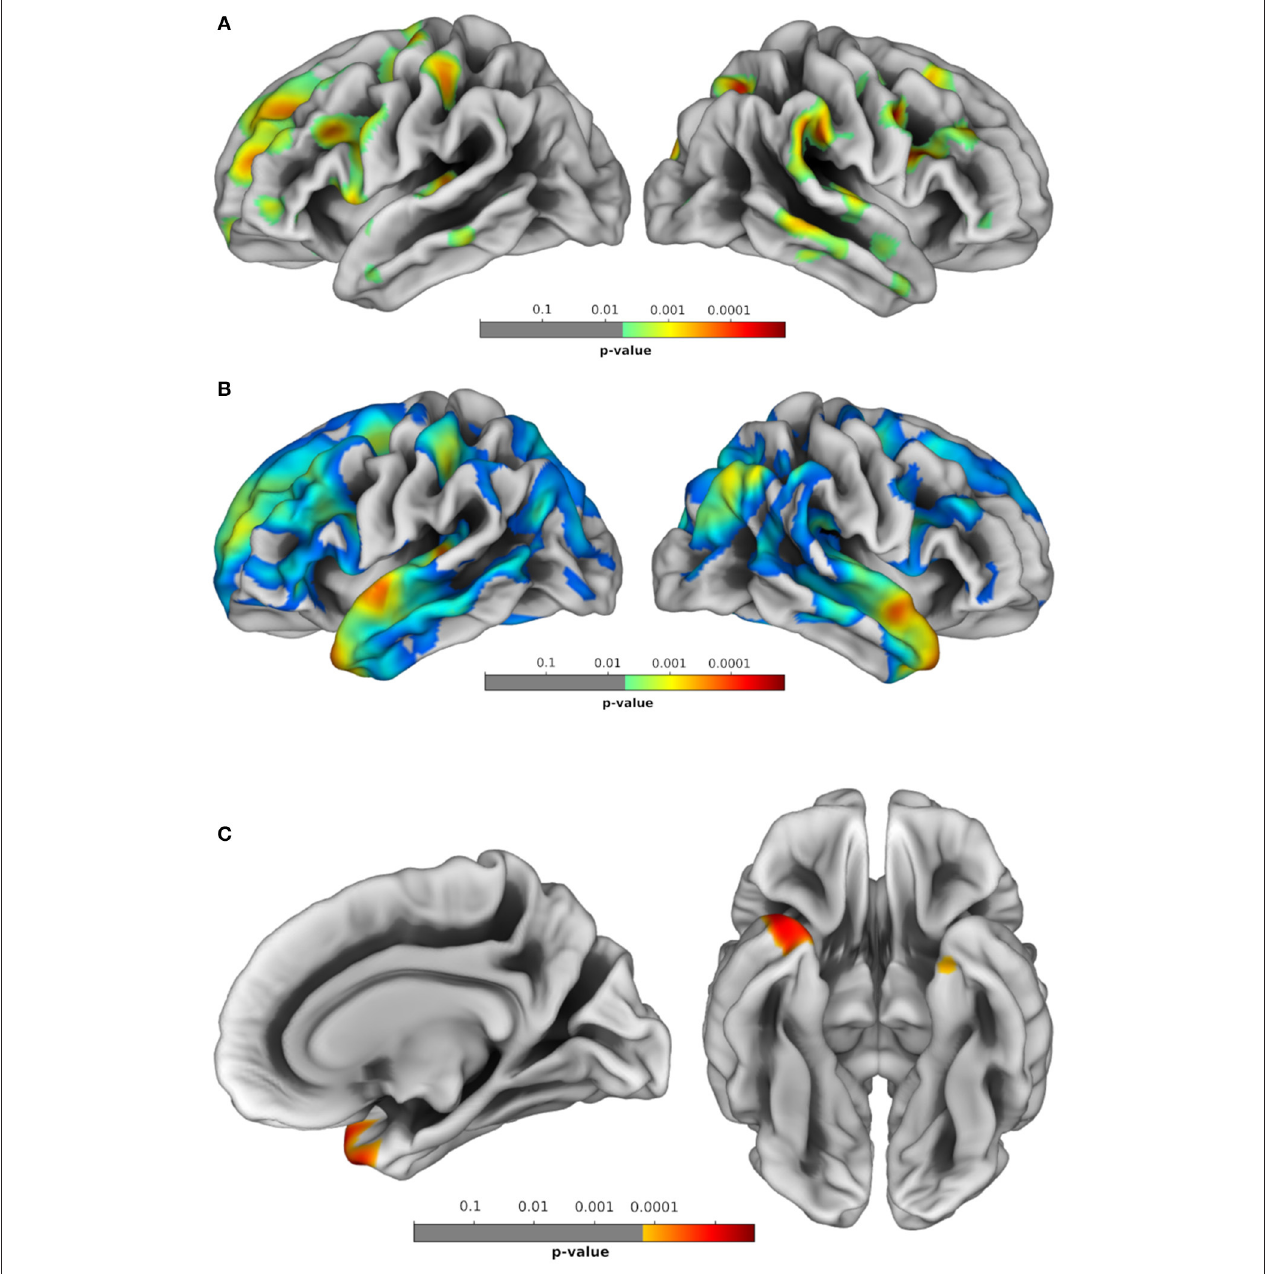
FIGURE 1 | Brain regions showing significant statistical differences between groups in morphometric profiles. (A) HC vs. EO-OABD; (B) HC vs. bvFTD; (C) EO-OABD vs. bvFTD. False discovery rate (FDR) correction for multiple comparisons was applied with cluster significance of p < 0.05 and cluster size > 30. HC, healthy controls; EO-OABD, early-onset older-age bipolar disorder; bvFTD, behavioral variant of frontotemporal dementia.